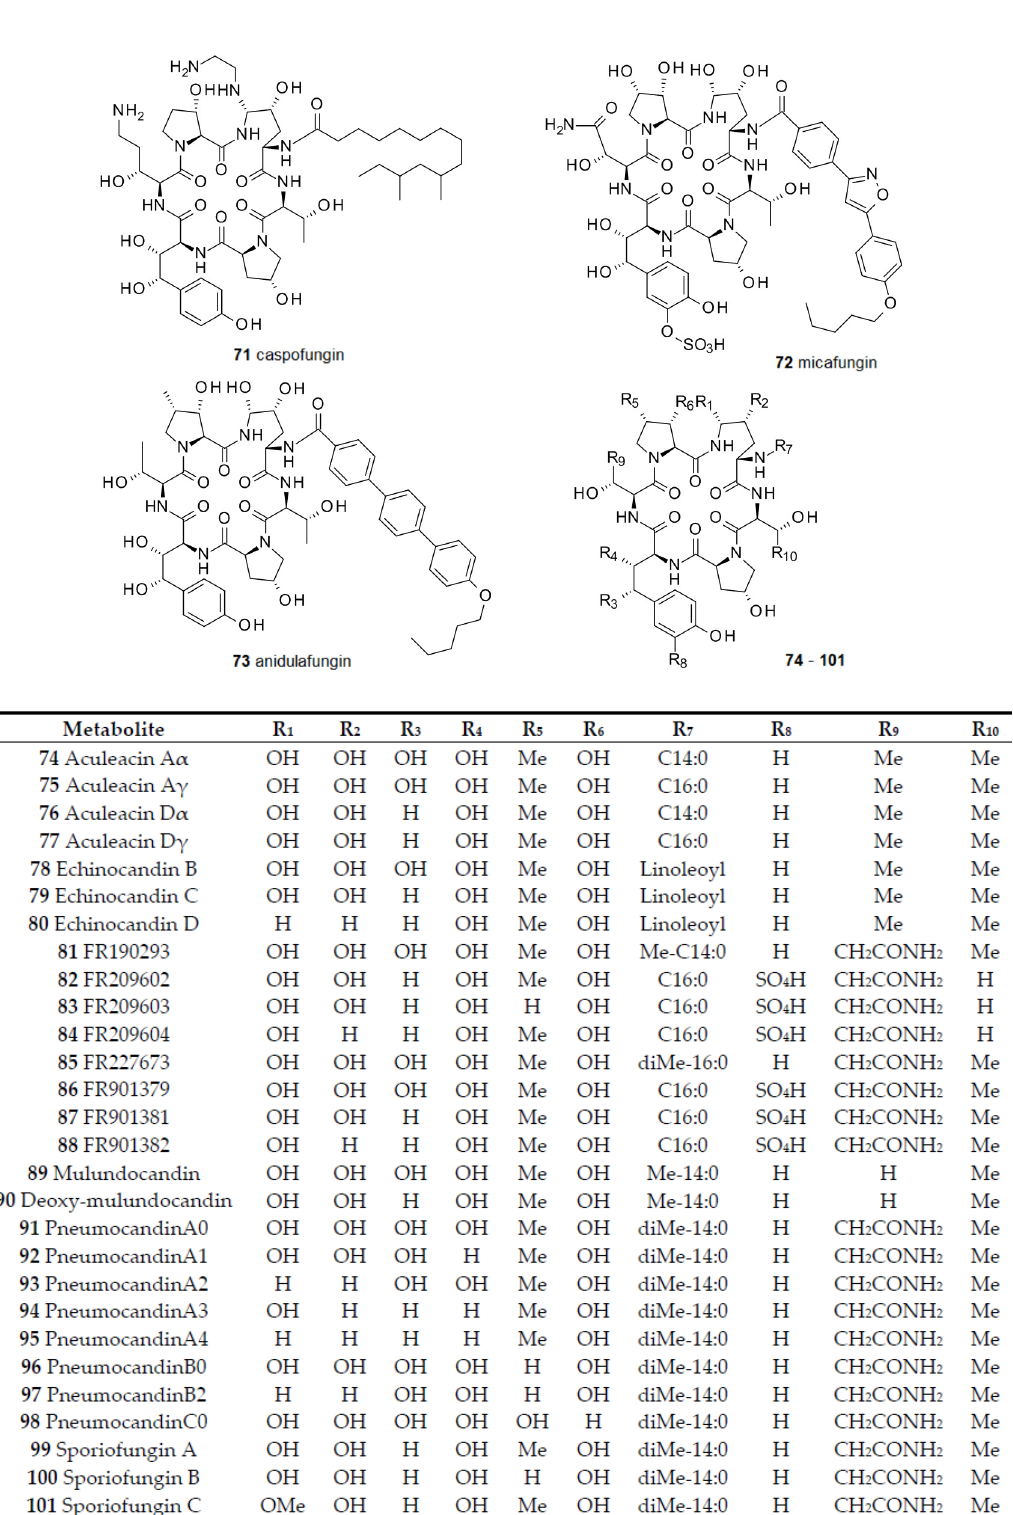
Figure 8. Secondary metabolites of the echinocandin-type active against several fungal pathogens organized in biofilms. C14:0 = tetradecanoic acid, C16:0 = hexadecanoic acid,